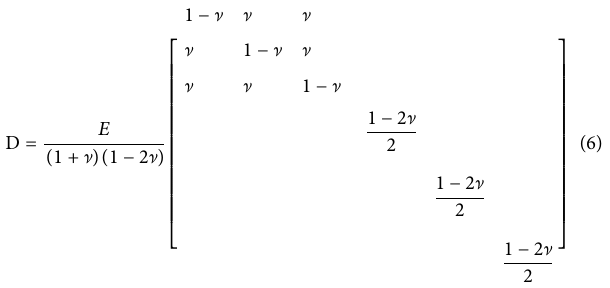
Figure 4 . Three types of boundary conditions are used in the geometry. The fi rst type is the axial stress exerted at the top of the cylindrical domain. It is used to represent the time-dependent axial load in the GCTS testing system. The second type is the con fi ning stress or con fi ning pressure exerted radially. This is used to represent the con fi nement in the testing system. The third type is the fi xed bottom boundary.